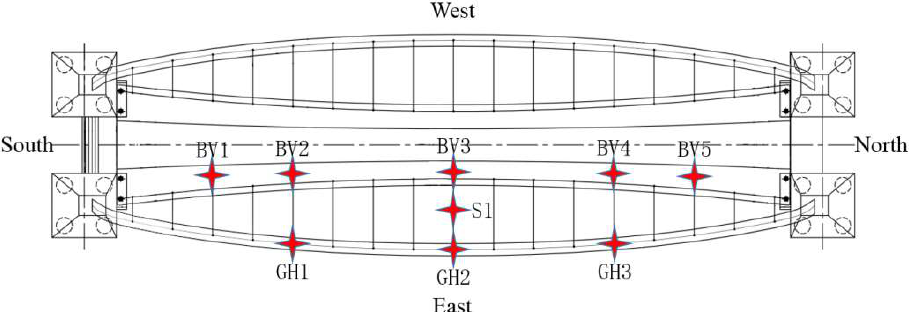
Figure 11. Distribution of the accelerometers.